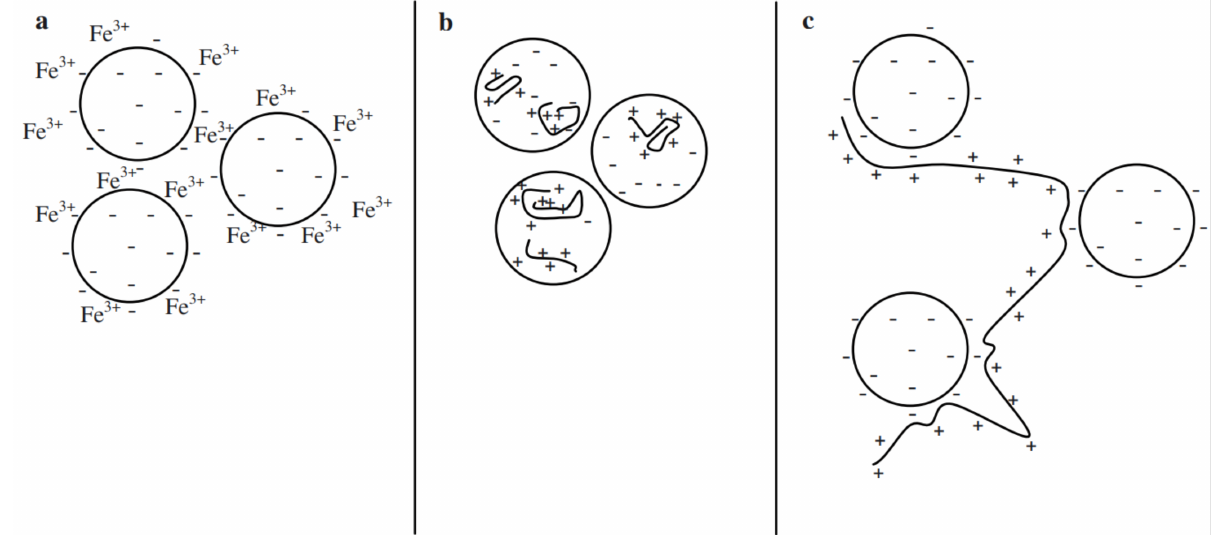
Figure 4. Diagrammatic representations of ( a ) coagulation, ( b ) patch flocculation and ( c ) polymer bridging (reproduced by permission from Hjorth et al. 2008